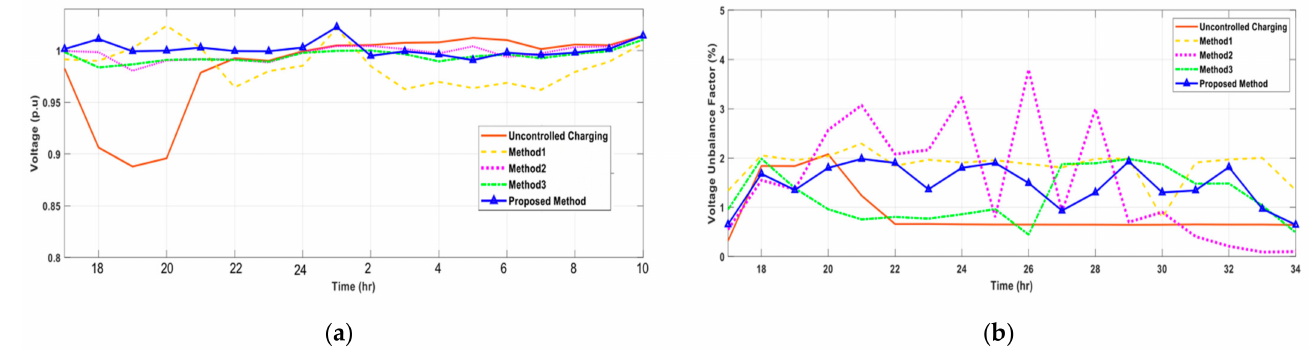
Figure 20. Bus 846 ( a ) voltage and ( b ) VUF for weekend electric load profiles.